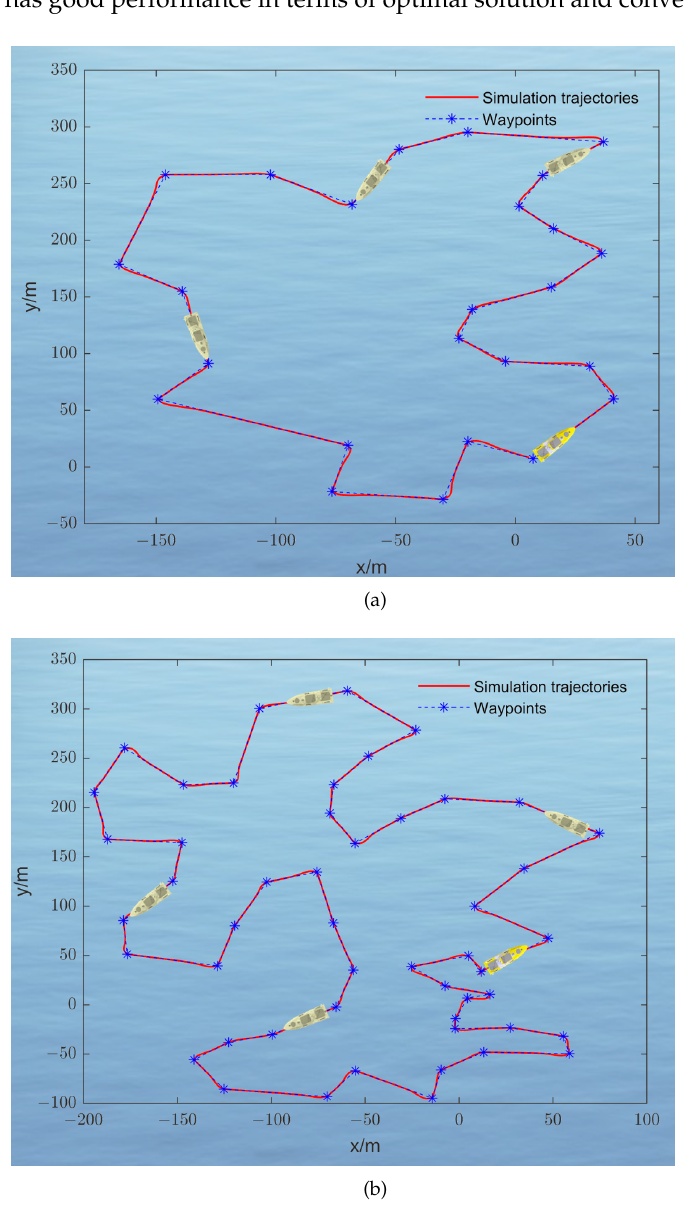
Figure 11. Simulated USV path tracking results at 25 and 50 waypoints. ( a ) Simulated USV path tracking results at 25 waypoints. ( b ) Simulated USV path tracking results at 50